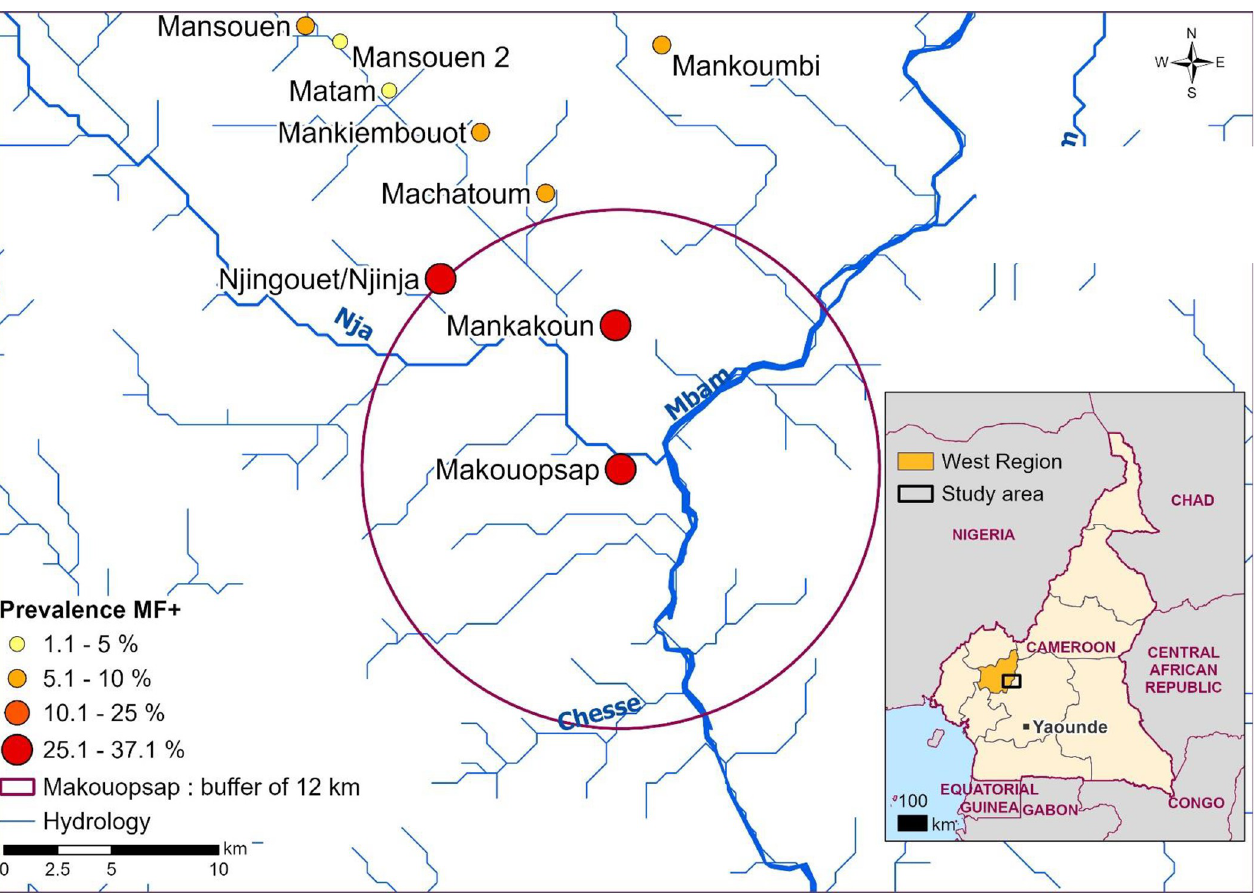
Fig 1. Map of Massangam Health Area showing area of intervention (circle). Circle indicates high transmission foci communities (high transmission focus) where doxycycline and ivermectin treatment were implemented [18]. In the rest of the communities, only biannual ivermectin mass drug administration was implemented. Larviciding was implemented in Njah and Mbam rivers following baseline survey that identified breeding sites contributing to transmission in the area [15]. (Sources: Hydrology-HydroSHEDS https://www.hydrosheds.org/; the administrative boundaries—Natural Earth